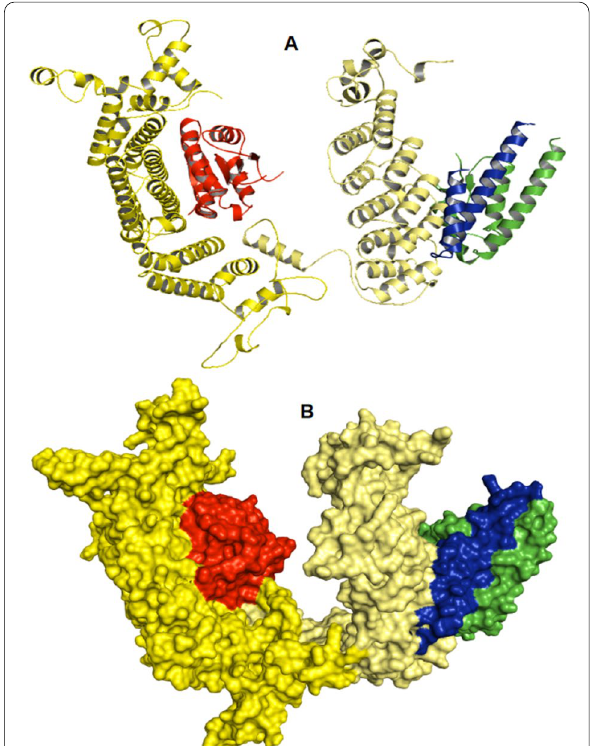
Fig. 3 Cartoon and surface representation of the ( A ) fungal (PDB 5Z08), ( B ) yeast (PDB 6YPC), and ( C ) human model of the CENP-HIK structural architecture. All CENP-H ( th CENP-H 184 − 227 , sc CENP-H 147 − 181 , and hs CENP-H 194 − 247 ) are sandwiched between CENP-I ( ct CENP-I 8 − 229 , sc CENP-I 2 − 241 , and hs CENP-I 1 − 265 ) and CENP-K ( th CENP-K 161 − 328 , sc CENP-K 136 − 237 , and hs CENP-K 161 − 269 ). The blue, green and pale yellow colors denote CENP-H, CENP-K and CENP-I, respectively, for all species